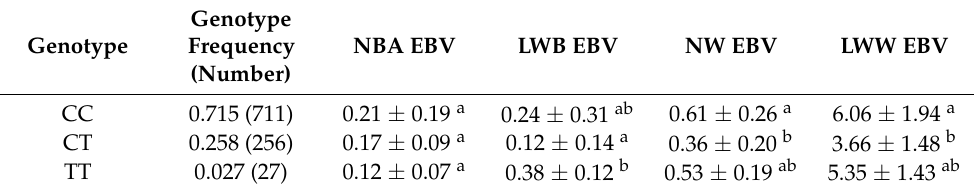
Table 3. Multiple comparisons between genotypes of SNP rs81471943 and estimated breeding values (EBVs) of reproductive traits in Duroc pigs.